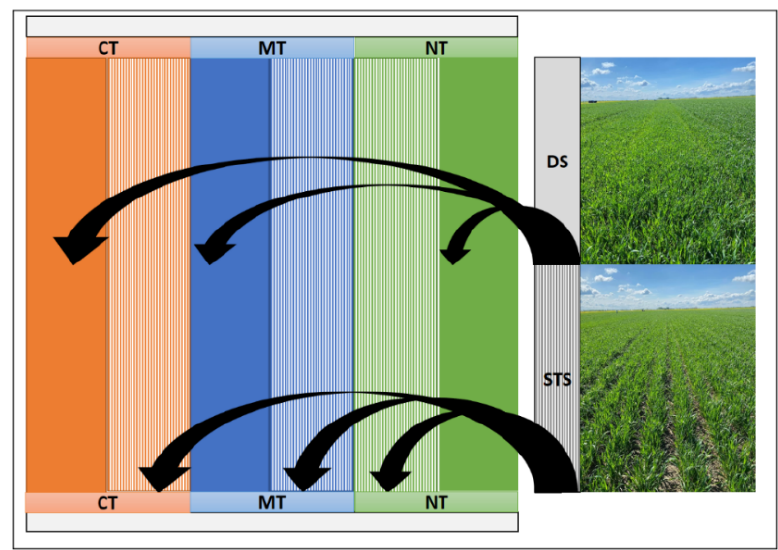
Figure 2. Scheme of tillage and sowing technological operations: CT—conventional tillage; MT— minimal tillage; NT—no tillage; DS—direct sowing; STS—strip tillage and sowing.